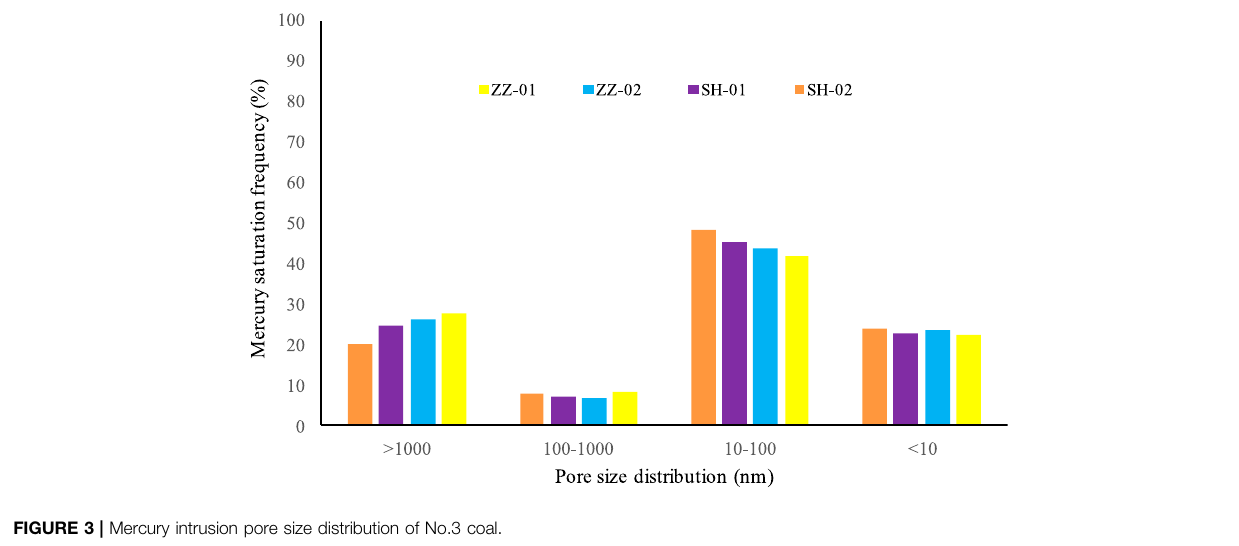
FIGURE 3 | Mercury intrusion pore size distribution of No.3 coal.